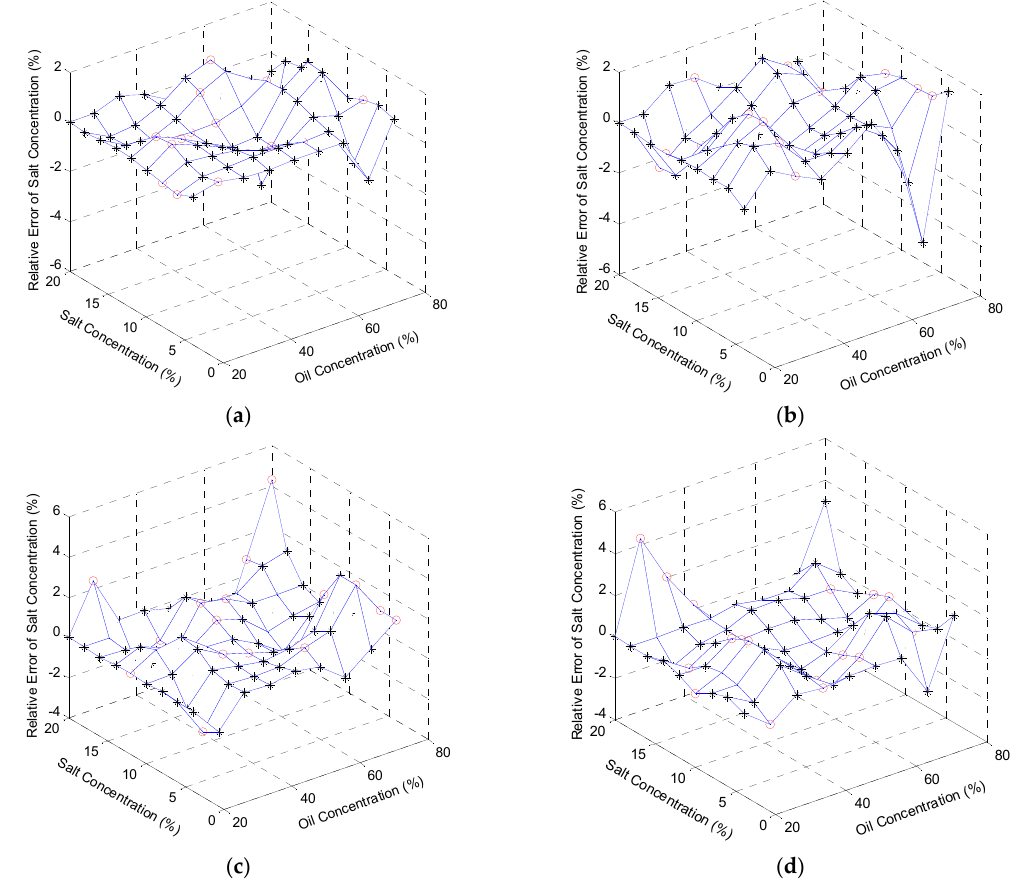
Figure 8. Relative error of reconstructed salt concentration at: ( a ) 5 °C; ( b ) 15 °C; ( c ) 25 °C; and ( d ) 35 °C. Black stars (*) stand for the relative errors of the training data, and red circles (o) represent those of the testing data.